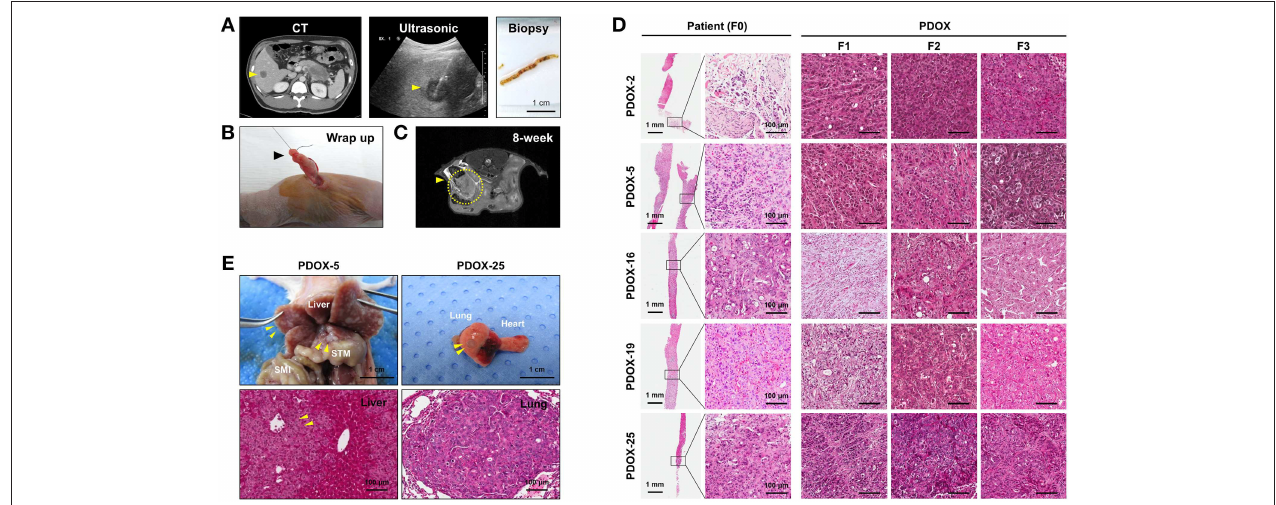
FIGURE 1 | Establishment of PDOX from a percutaneous liver biopsy (PLB) of metastatic pancreatic cancer. (A) Preparation of needle biopsy. Abdominal CT, ultrasonography and image of a patient who underwent PLB. Scale bar = 1cm. (B) Method for orthotopic implantation of a needle biopsy sample. An incision and wrapping were made in the tail of an exposed pancreas, followed by suturing of the biopsy. (C) Monitoring of tumor volume by magnetic resonance imaging (MRI) in PDOX models. (D) Retention of histopathological features of primary tumors by PDOX tumors. H&E staining showed similar histological morphologies of PDOX tumors (F1, F2, and F3) and the PLB sample from a patient (F0). Scale bars = 1mm, 100 µ m. (E) Top, Distant metastasis in the PDOX model. Images from laparotomy of the PDOX 3 months after orthotopic implantation of a PLB sample. The yellow arrows indicate liver metastases. Scale bar = 1cm. SMI, small intestine; STM, stomach. Scale bar = 1cm. Bottom, H&E staining of the metastatic liver (left bottom) and lung (right bottom) in the F1 xenograft were similar to that of the original primary tumor shown in (D) . Scale bar = 100 µ